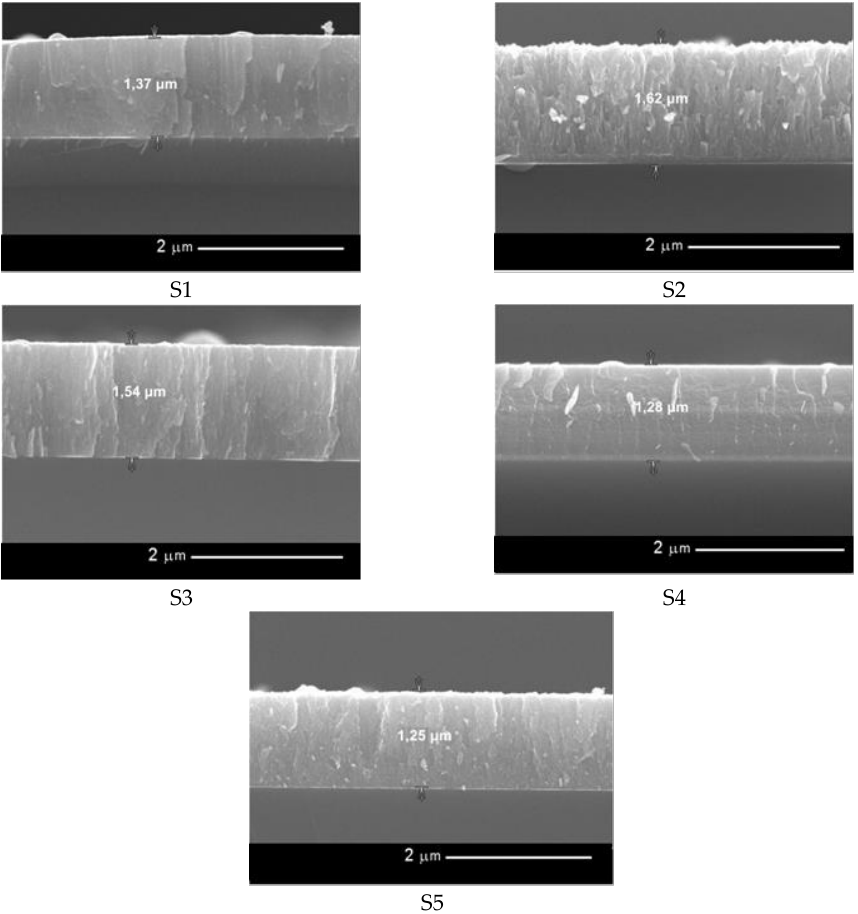
Figure 2. Cross-sections of particular coatings.